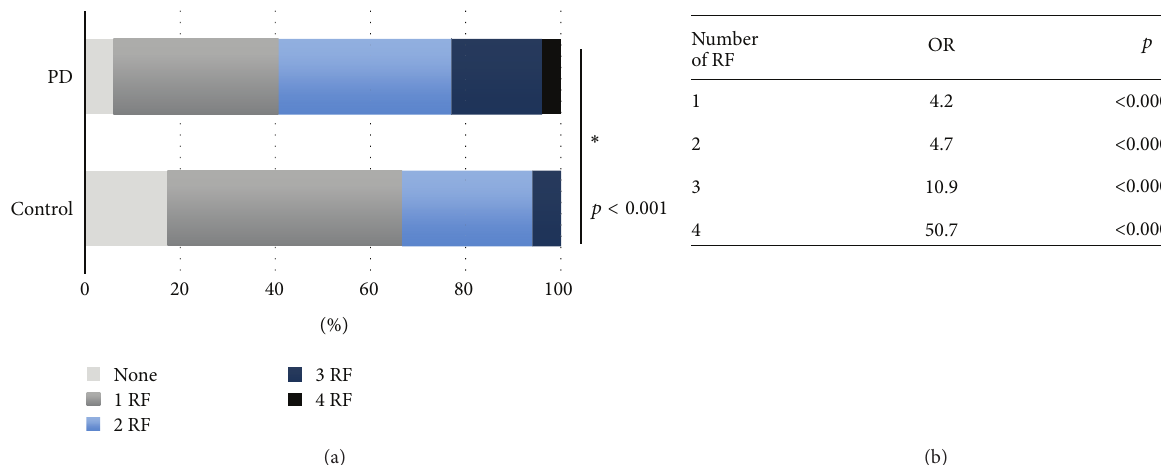
Figure 4: (a) Distribution of the number of concurrent risk factors (RF) in the two groups. (b) OR calculated for number of concurrent risk factors. ∗ means statistical